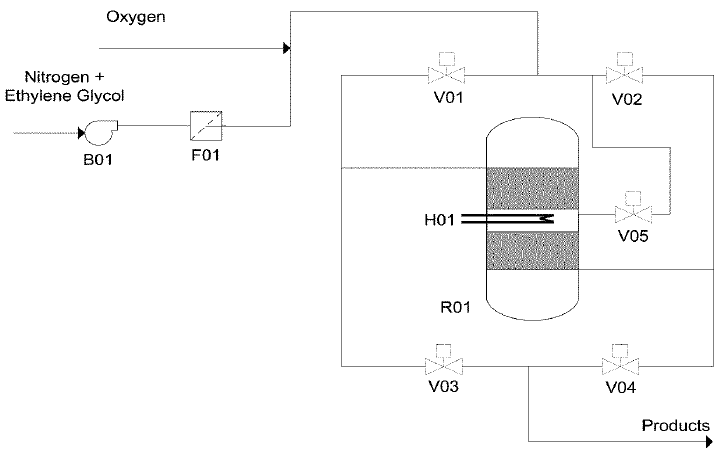
Figure 2. Sketch of the plant for the treatment of air-VOC mixtures in a reverse-flow reactor. With respect to the alarms and control/protection systems, for the feeding/product lines, as well as for the gas blower and the filter, the same alarms previously described for the fixed-bed reactor based plant are used also in this case. The alarms and the control/protection systems used for the reactor are different, according to the system proposed by Barresi et al. [2] and based on the temperature measurement at the interface between the inert and the catalyst sections, where the reactor temperature is higher. In case this temperature is decreasing from the set-point value, when it reaches 410 °C, the heating capacity of H01 is set at the maximum value, the switching time is